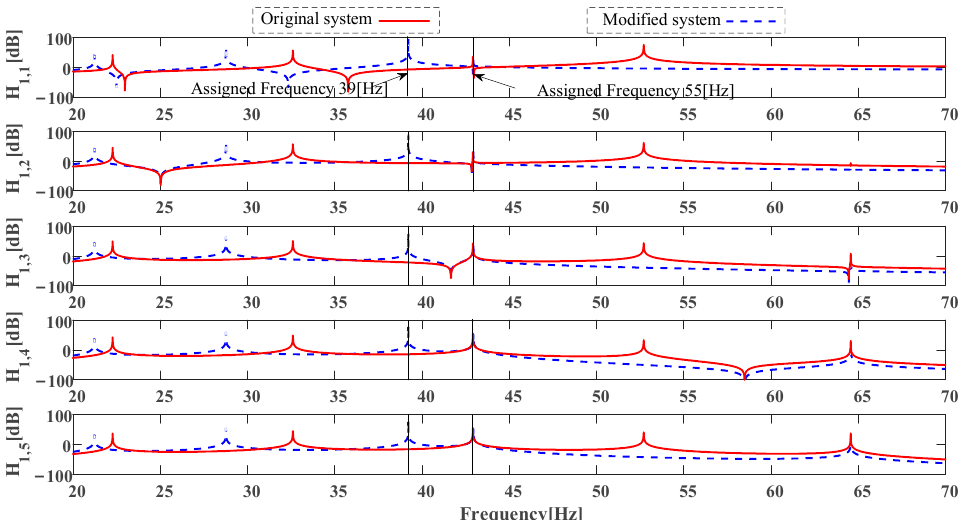
Figure 24. Original FRFs and FRFs after the addition of masses. Table 16. Comparison of natural frequencies and mode shapes.